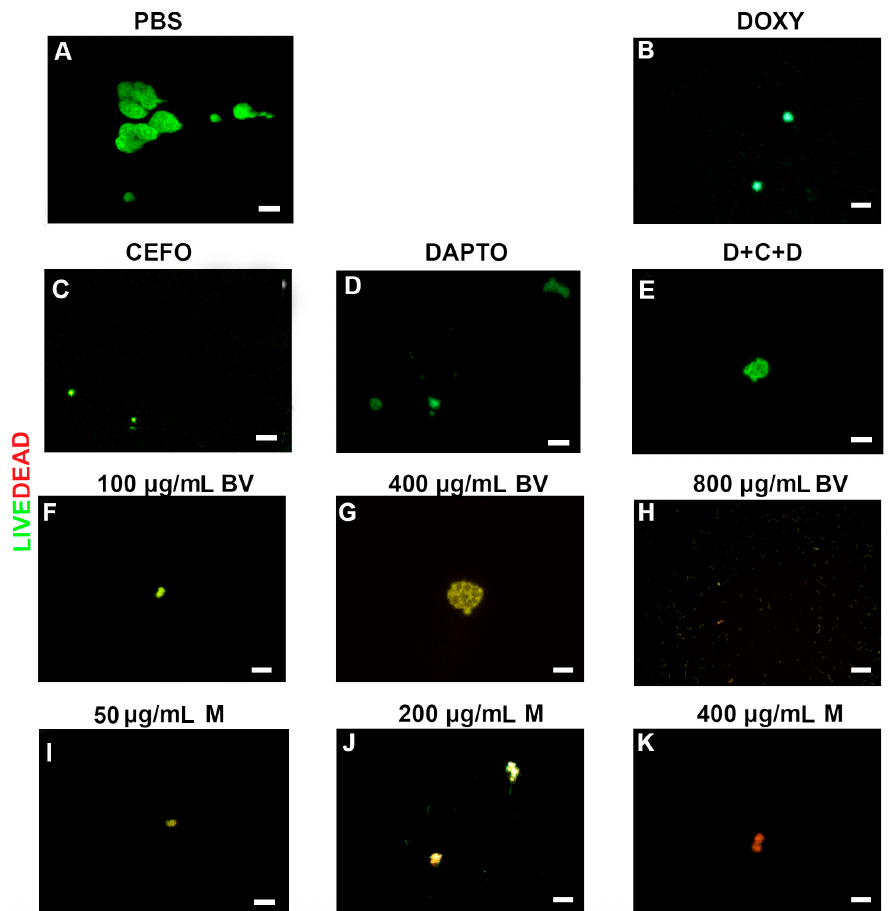
Figure 4. Representative Live/Dead staining images of B. burgdorferi 7-day recovery cultures following treatment with different antimicrobial agents. Cells were stained with SYBR Green I/PI as outlined in the Material and Methods and representative images were taken at 100 × magnification. Panel ( A ) Borrelia culture treated only with PBS was used as a negative control. Panel ( B ) Doxycycline (DOXY) treated, Panel ( C ) Cefoperazone (CEFO) treated, Panel ( D ) Daptomycin (DAPTO) treated and Panel ( E ) Three-antibiotic combination (D + C + D). Panels ( F – H ) Bee venom (BV) was used in increasing concentrations while Panels ( I – K ) depict melittin (M) treated cells at different concentrations. Live cells are stained with green color while dead cells are stained red. Scale bar: 100 μ m.